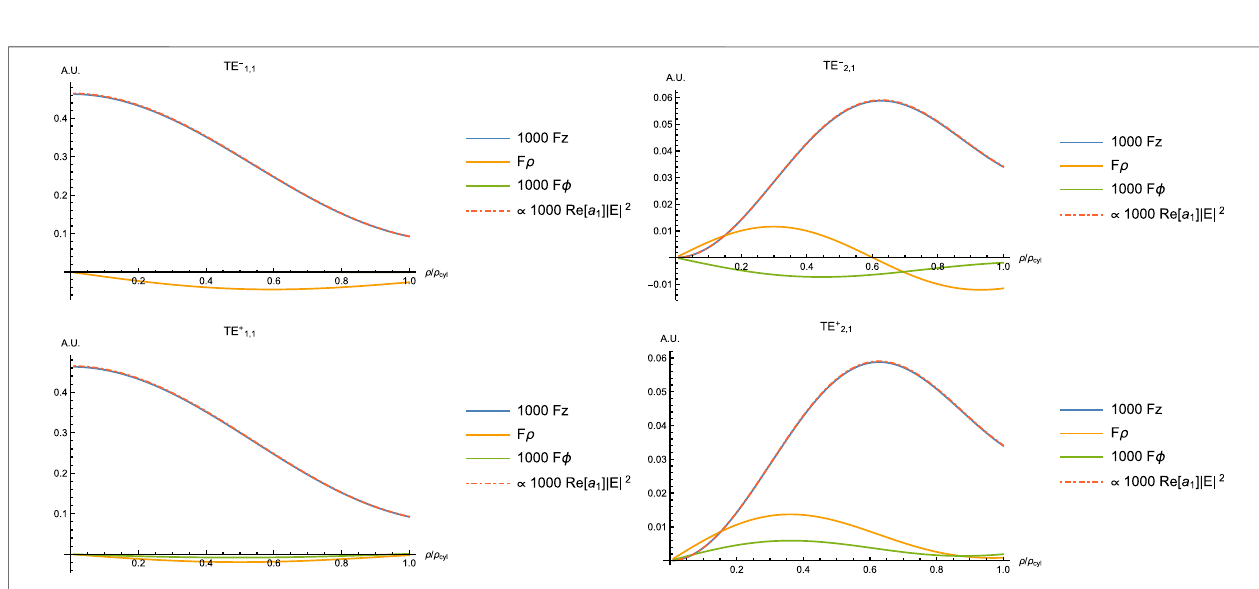
FIGURE 3 | Density plot of axial force as function of particle ’ s relative refractive index M and particle radius for a 10 μ m radius cylindrical waveguide.